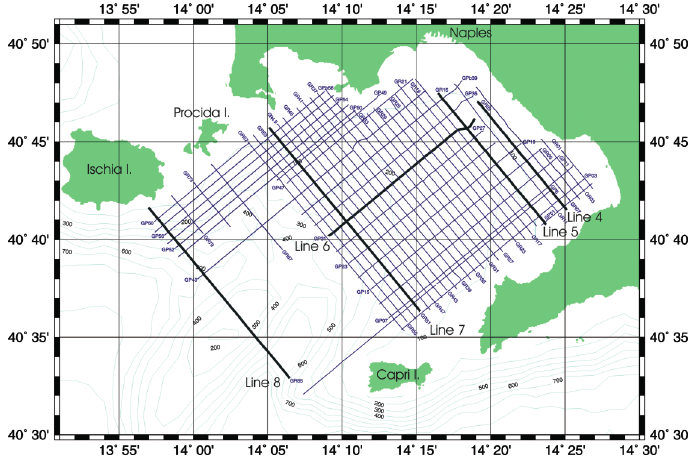
Fig. 3. Navigation map of magnetic and seismic lines recorded in the Gulf of Naples plus bathymetry (bold lines are shown and discussed in the